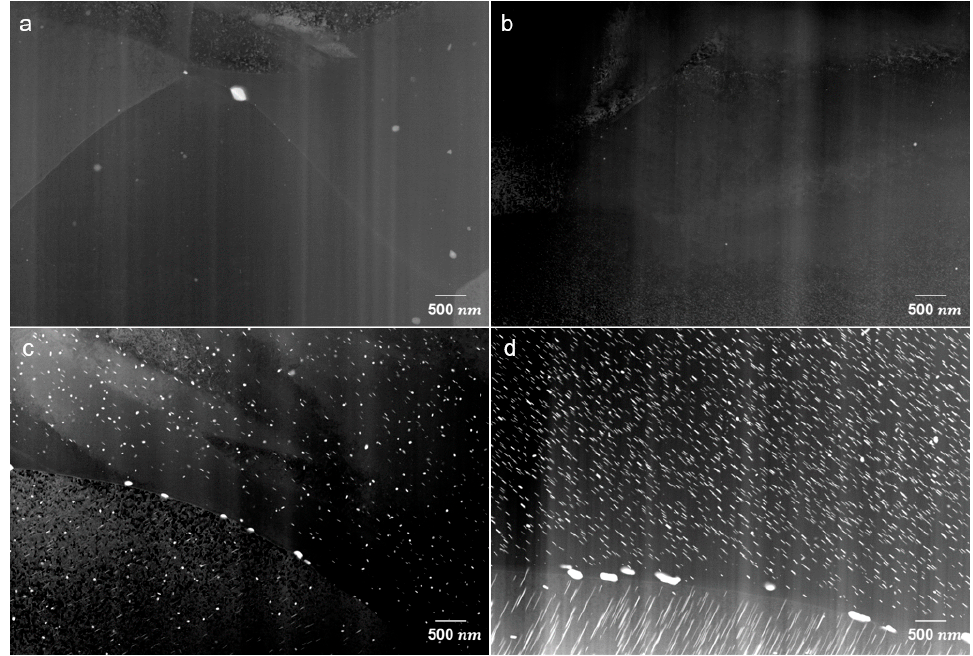
Figure 6. STEM images of (upper) homogenized and (below) peak-aged ( a , c ) ZAXM2100 and ( b , d ) ZAXM4100 alloy sheets. ( b , d ) ZAXM4100 alloy